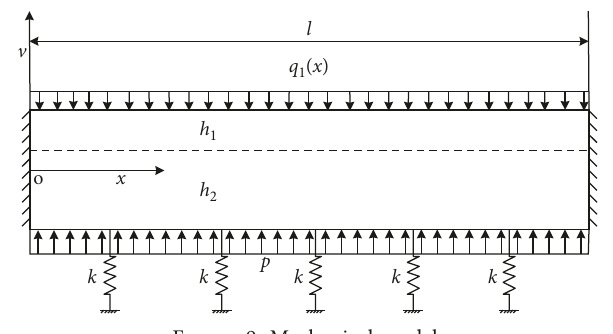
Figure 9: Mechanical